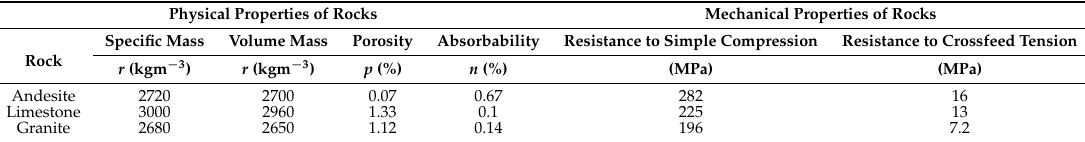
Table 2. Physical and mechanical properties of the rocks.